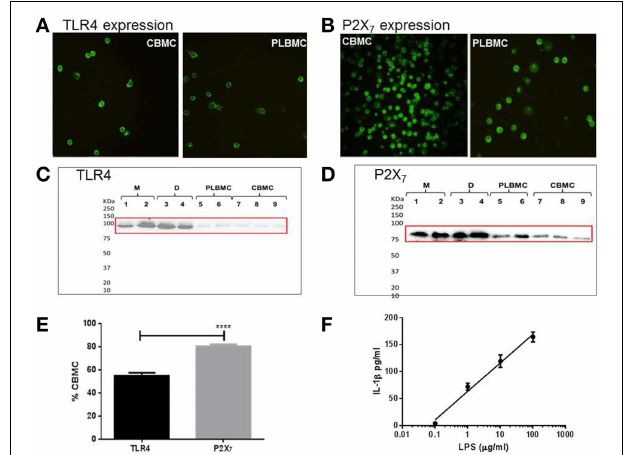
FIGURE 2 | Dot plot of leukocyte markers in isolated cells. Cells were prepared for flow cytometry then analyzed using fluorescence leukocyte markers CD45 (A) , CD14 (B) and CD68 (C) . Levels of CD14 (B) were lowest in PLBMCs, CBMCs, and MBMCs. (D) Dot plot for MBMCs.